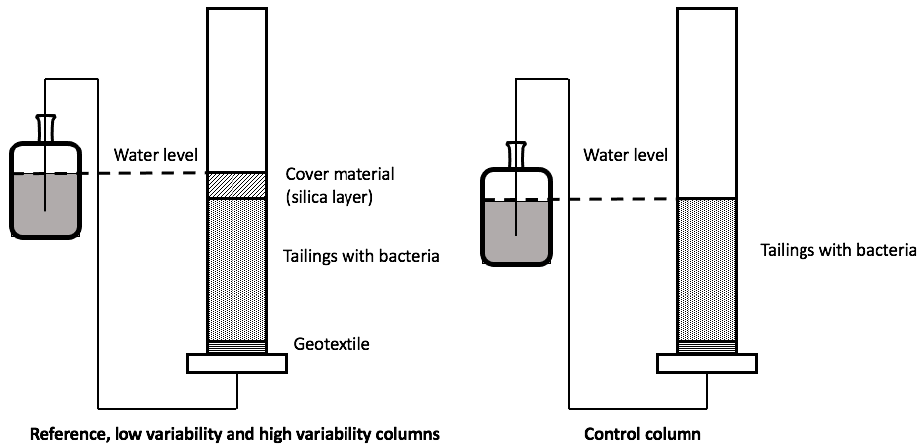
Figure 1. Visual representation of the experimental set-up and initial saturation of the